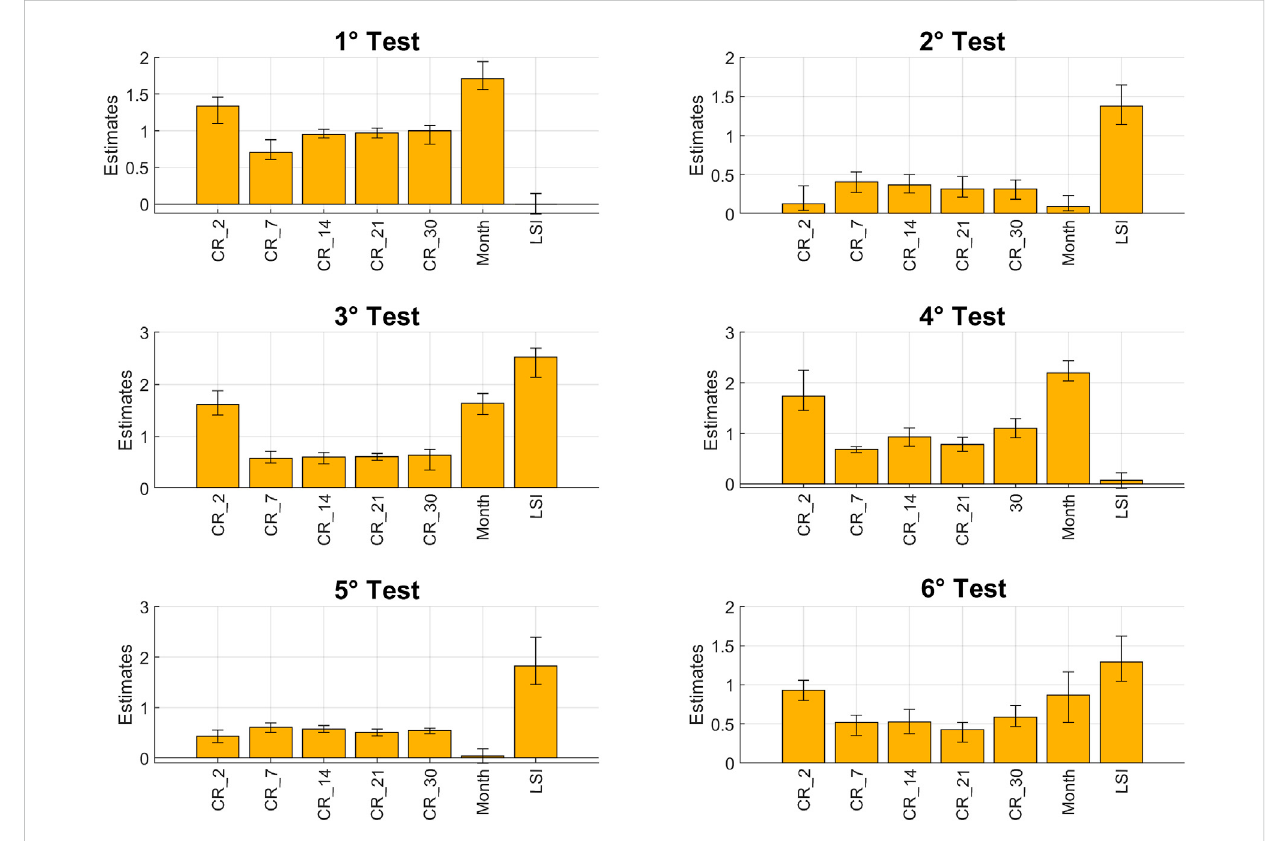
FIGURE 6 Histograms of OOB Permuted Predictions Importance Estimates for the third con fi